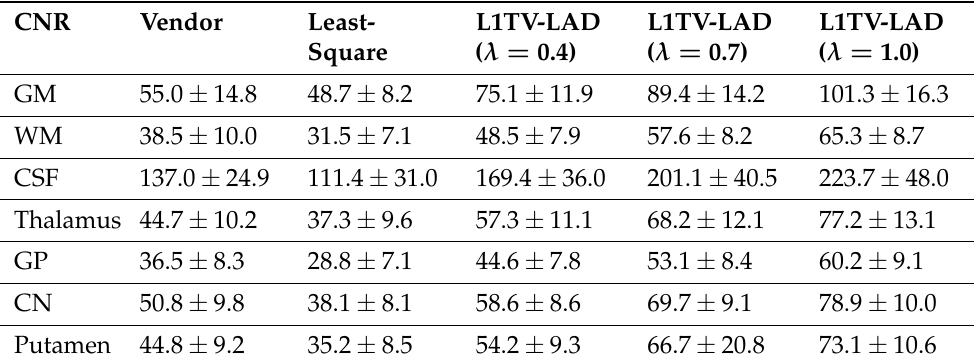
Table 3. Contrast-to-noise ratios (CNRs).